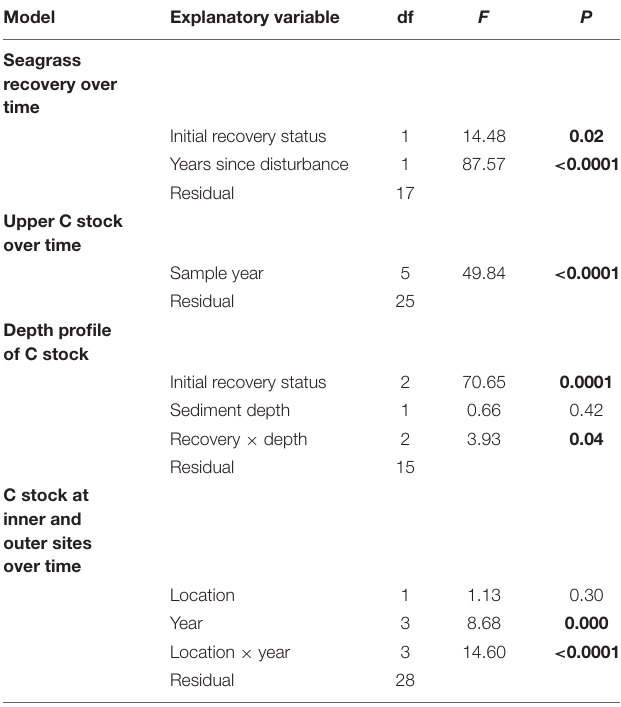
TABLE 1 | Summary of model results for the spatial and temporal analyses of sediment C